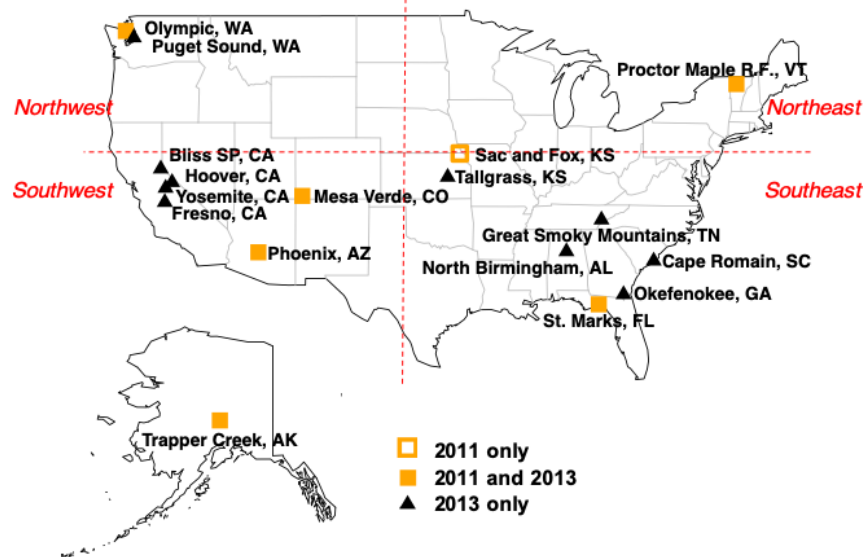
Figure 1. Map of IMPROVE network monitoring sites used in this work. For analysis in Sect. 4.4, the contiguous US is divided into four quadrants (vertical and horizontal dashed red lines centered at 40 ◦ N and − 100 ◦ W); Alaska is considered a separate